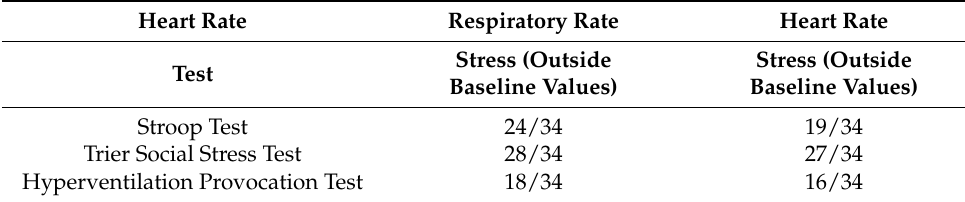
Table 6. Summary of Statistical Analysis (adaptive reference